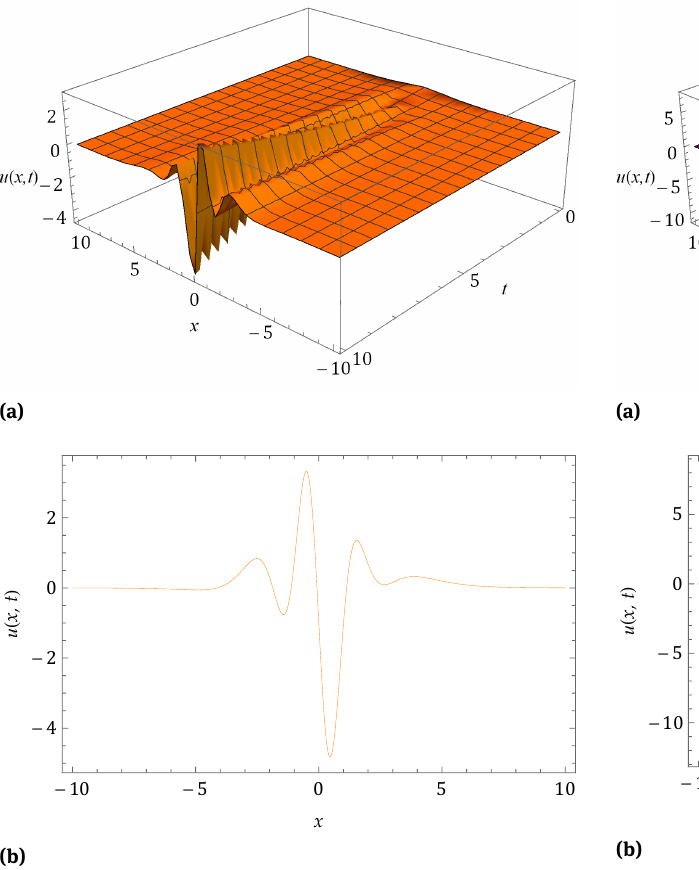
Figure 2: (a) Surface of u ( x , t ) , ( b ) 2D plot of u ( x , t ) at t = 10 at µ = 0.5, (cid:125) = −1, n = 1 and α = 0.75